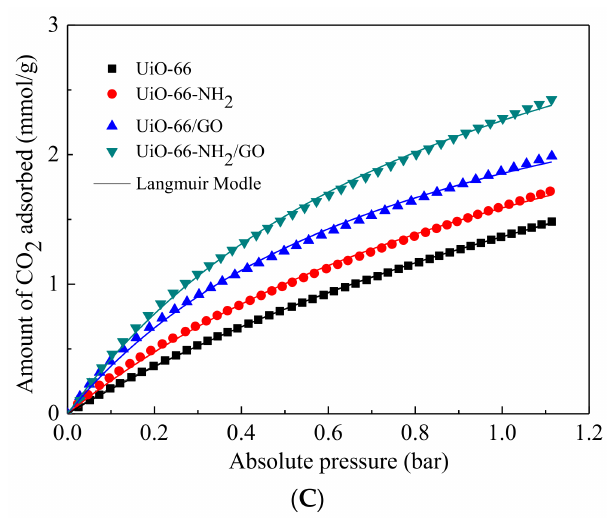
Figure 8. CO 2 adsorption isotherms measured at 273 K ( A ); 298 K ( B ); and, 318 K ( C